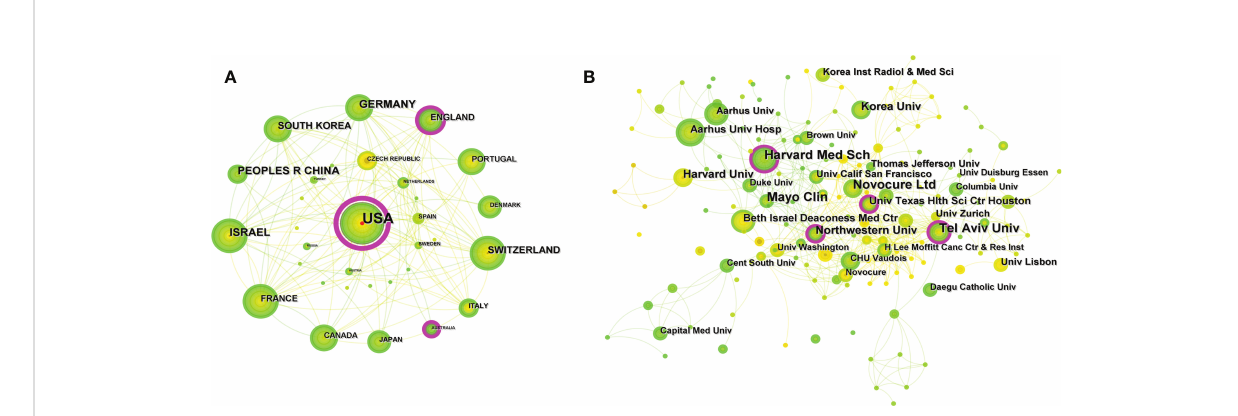
FIGURE 3 (A) Visual mapping of cooperative relationships between countries/regions in related publications. A circle represents a country/region, with larger circles representing more publications and the purple circle on the outer ring representing a higher centrality. (B) Visual mapping of collaborative relationships between related publication institutions. A circle represents an institution, the larger the circle means more publication, and the outer purple circle represents having a higher centrality.